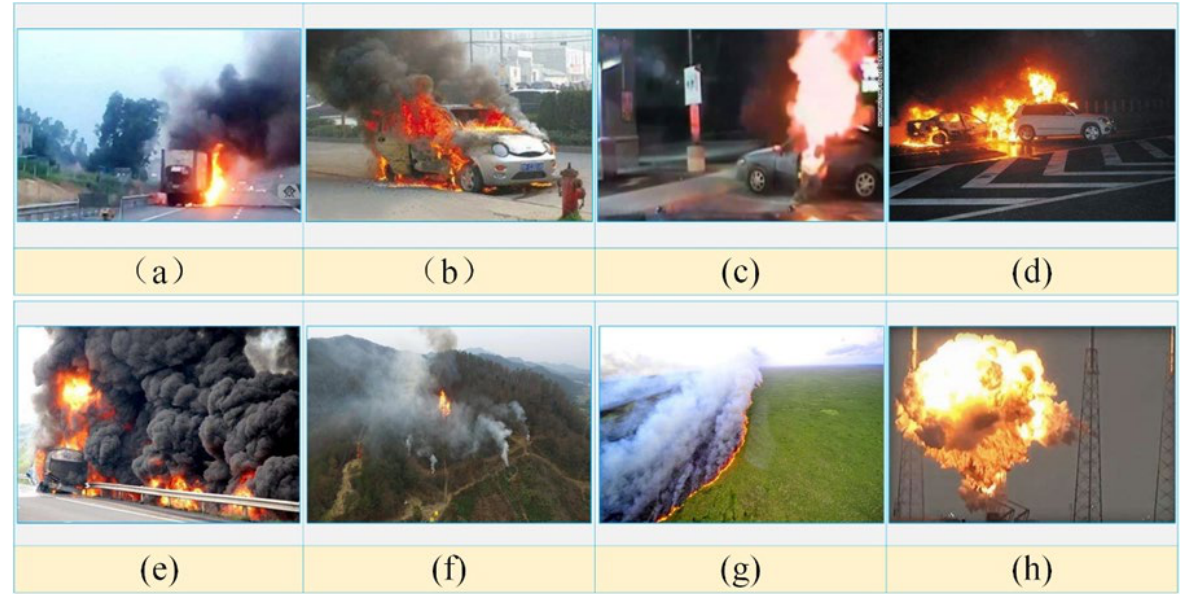
Figure 2. Flame characteristics under different conditions. Figure 2a,b shows that vehicles caught fire at different distances under light conditions. Figure 2c,d shows that vehicles caught fire at various distances in dark conditions. Figure 2e represents the flame covered by dense smoke. Figure 2f represents a small flame at a long distance. Figure 2g represents a long line of irregular side flame. Figure 2h represents a spherical, irregular side